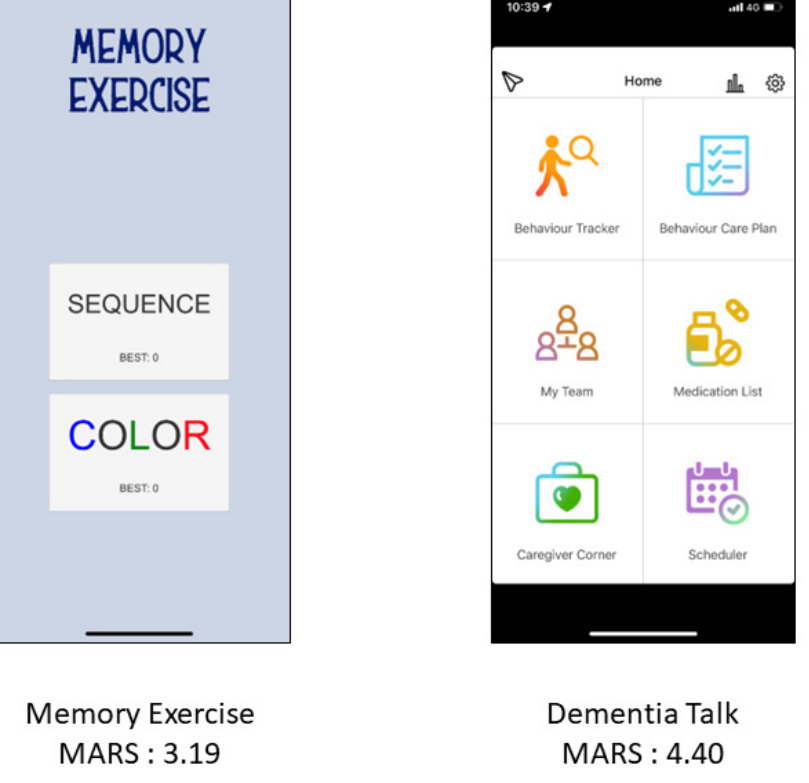
Figure 2. Two application interfaces with MARS